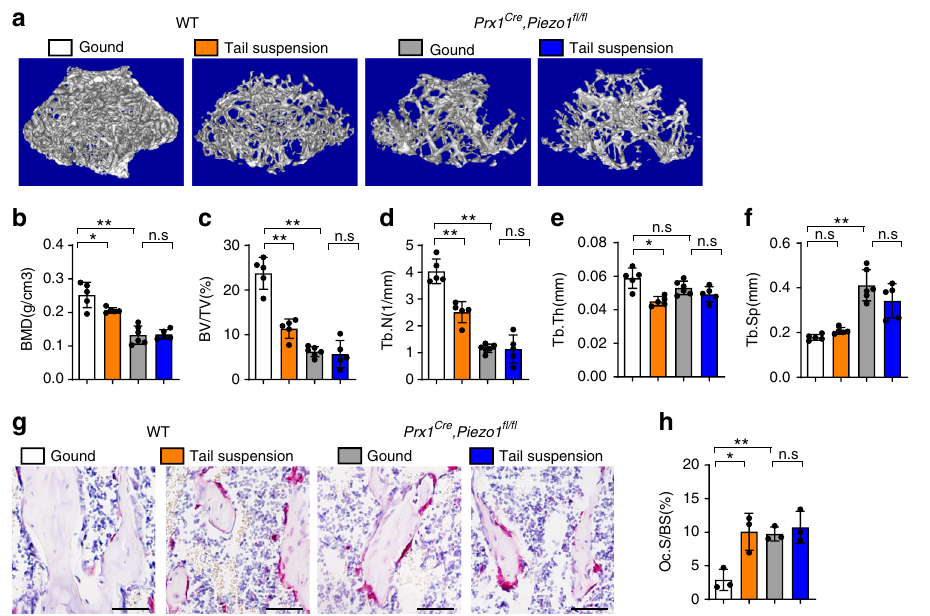
Fig. 4 Piezo1 de fi ciency resisted to bone loss induced by unloading. a 3D μ -CT images of trabecular bones of distal femurs isolated from male WT and Prx1 Cre , Piezo1 fl / fl mice, subjected with tail-suspended for one week trial or ground control, respectively, sacri fi ced at 7-week-old. b – f μ -CT analysis of distal femurs for bone mineral density (BMD) ( b ), bone volume per tissue volume (BV/TV) ( c ), trabecular number (Tb.N) ( d ), trabecular thickness (Tb.Th) ( e ) and trabecular spacing (Tb.Sp) ( f ). Data are mean ± SD, n ≥ 5. g TRAP staining of the femurs isolated from male WT and Prx1 Cre , Piezo1 fl / fl mice, subjected with tail-suspended trial or ground control, respectively. Scale bar = 50 μ m. h Quanti fi cation of the TRAP staining by osteoclast surface per bone surface (Oc.S/BS). Data are mean ± SD, n = 3. * P < 0.05; ** P < 0.01. Ordinary one-way ANOVA. Source data are provided in the Source Data (Fig. 6h, i). To exclude the function of XMU-MP-1 on osteoclasts, we treated bone marrow monocytes with XMU-MP-1 during